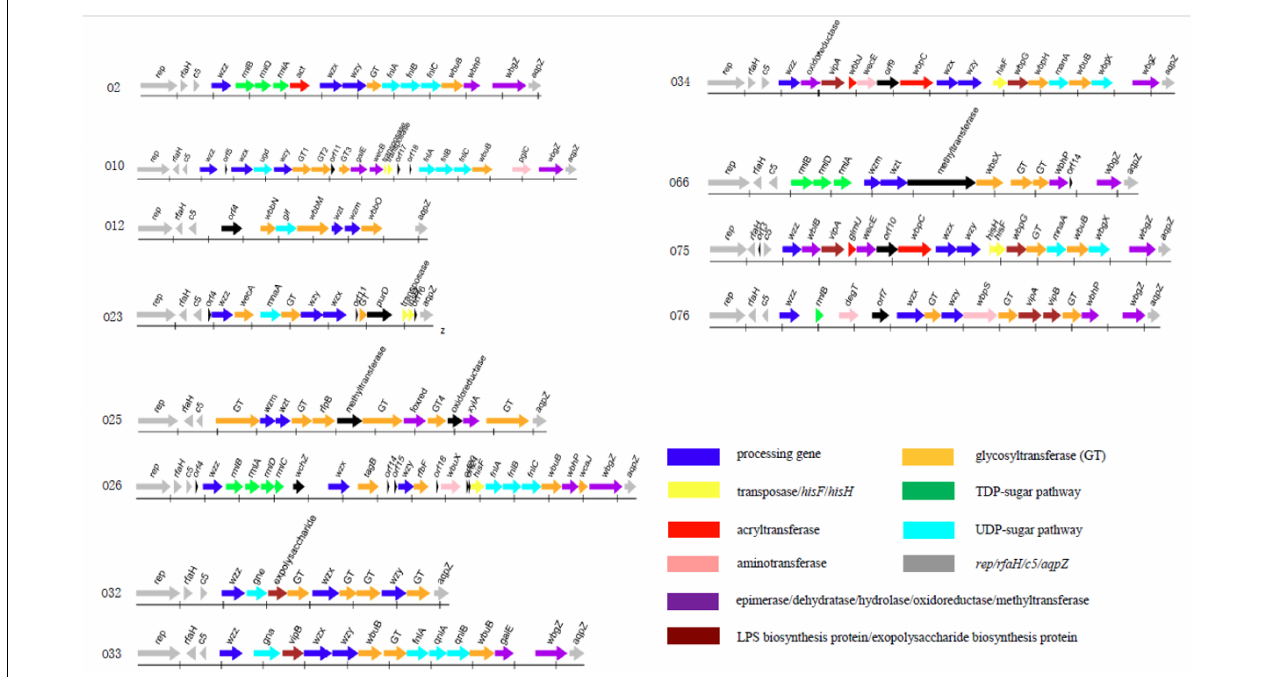
FIGURE 1 | The O-antigen gene clusters of 12 P. shigelloides serogroups O2, O10, O12, O23, O25, O26, O32, O33, O34, O66, O75, and O76.